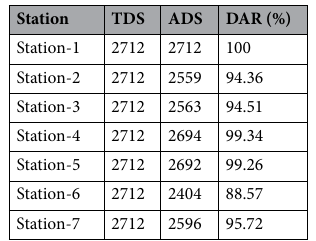
Table 3. Comparison of the actual data acquisition rates of multiple